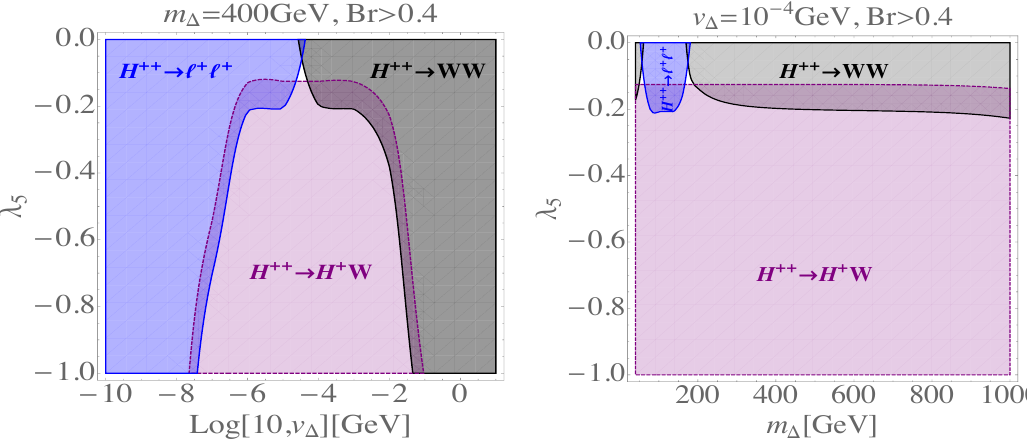
Figure 5 . Decay region plots for H (cid:6)(cid:6) with BR (cid:21) 40%. Left panel is with m (cid:1) = 400 GeV and right panel is with v (cid:1) = 10 (cid:0) 4 GeV. Purple region is the H (cid:6) W (cid:6) channel, black is the same-sign di-W boson channel and blue is the same-sign di-lepton channel. (cid:21) 5 is in the negative region to be consistent with the NMH